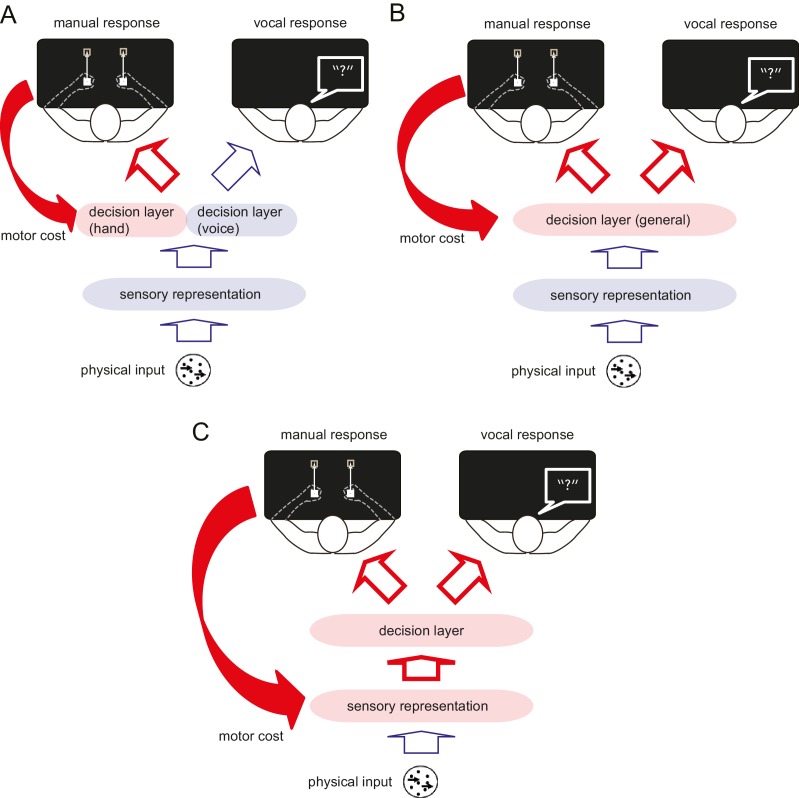
Schematic diagram illustrating the process of perceptual decision making, and the possible influence of the motor cost on the decision process.Perceptual decision making consists of three different processing stages. First, the features of the sensory input are extracted and encoded as in the sensory representation. Second, the perceptual (categorical) decision is made based on this sensory representation (decision layer). Finally, the decision is transferred to the response effector. The motor cost asymmetry during the manual response can affect the perceptual decision making process in several different ways. (A) The motor cost for the manual response may only bias the decision layer that involves this response, but leave the decision layer for different response effectors unaffected. If this is the case, the bias observed during the manual response should not generalise to the verbal response. (B) The motor cost may bias the decision layer in general or (C) the sensory representation directly. In either of the latter two cases, the effect of motor cost should be also observable during the response using the different effector.